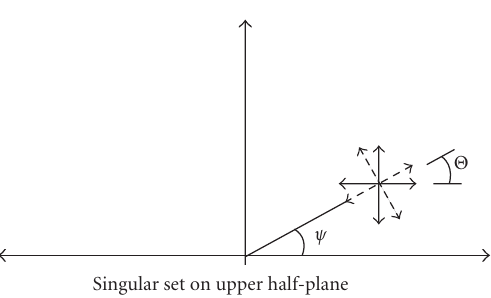
Figure 2.1. Singular set (cid:1) k , γ